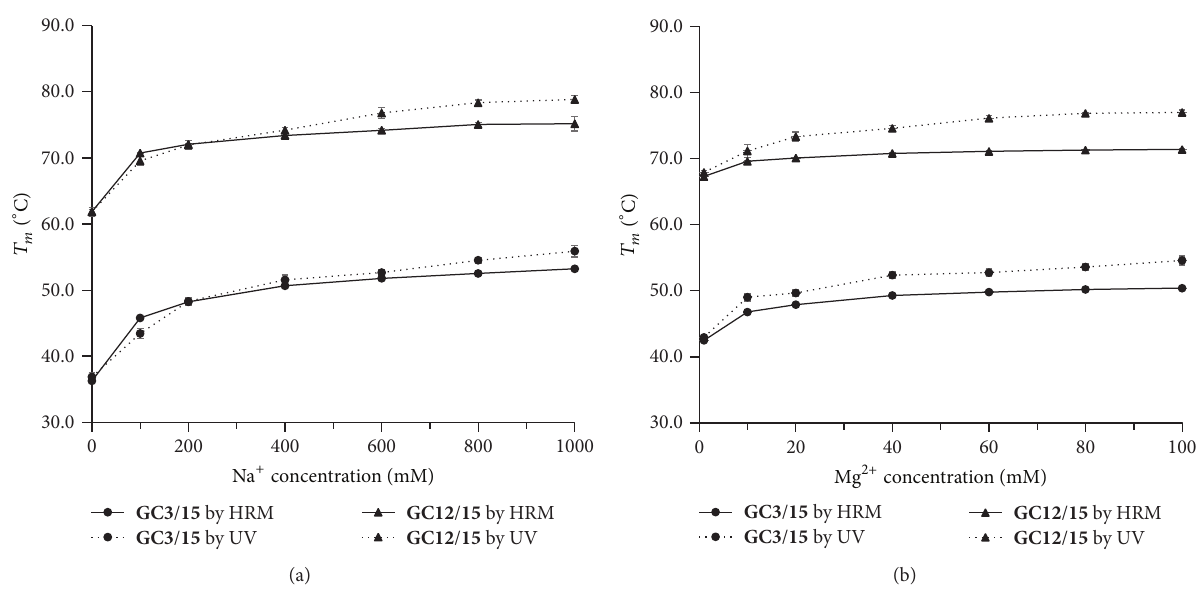
Figure 4: Effect of Na + or Mg 2+ on 𝑇 𝑚 measurement by HRM. 𝑇 𝑚 s of DNA duplex GC3/15 and GC12/15 were measured by HRM with NaCl at various concentrations from 0 to 1M (a) or with MgCl 2 from 1 to 100 mM (b). The corresponding 𝑇 𝑚 s were measured by